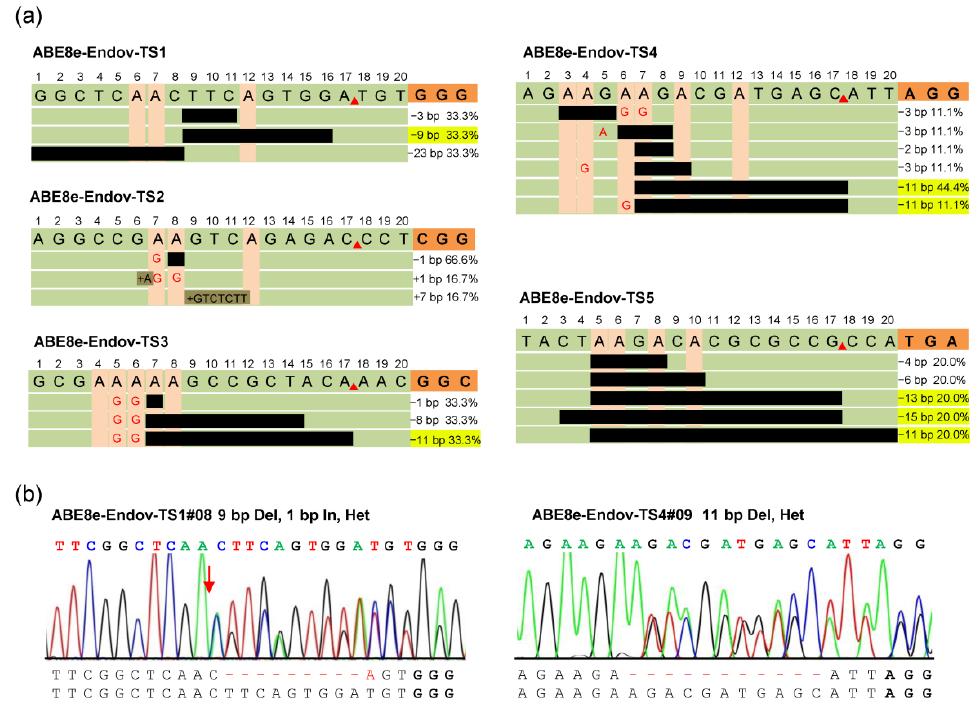
Figure 3. ABE8e-EndoV exhibits predictable small DNA fragment deletions. ( a ) ABE8e-Endov generates precise deletions from the 5 ′ -deaminated A base to the SpGn nicking site. The proportion of deletions versus total indels is shown below PAM, and the uniform precise deletion ratio is highlighted in yellow; PAMs are highlighted in orange, and black bars represent the deleted nucleotide fragment. ( b ) Sanger sequencing chromatogram for some typical mutation types of ABE8e-Endov. Het, heterozygous mutation; Del, deletion; In, insertion.